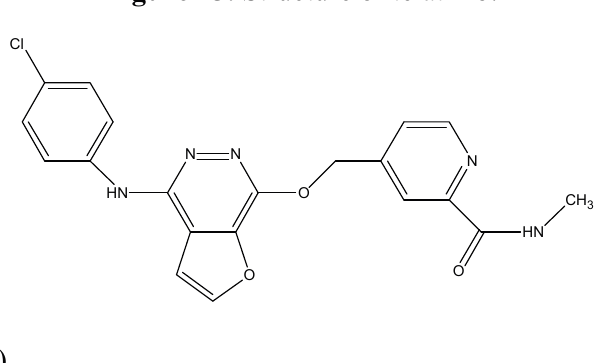
Figure 13. Structure of telatinib.